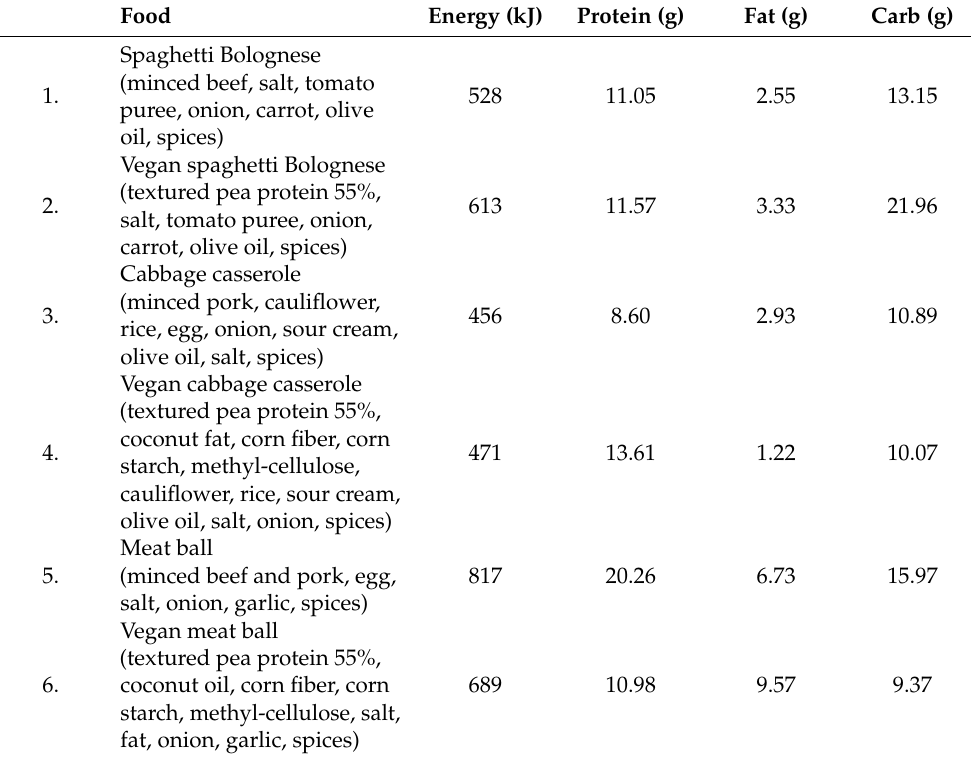
Table 1. Food samples, ingredients, and nutritional